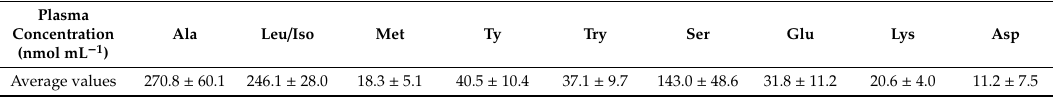
Table 5. Average values of the AA and NT plasma concentrations (with standard deviation) determined in plasma samples from six schizophrenic patients (n =